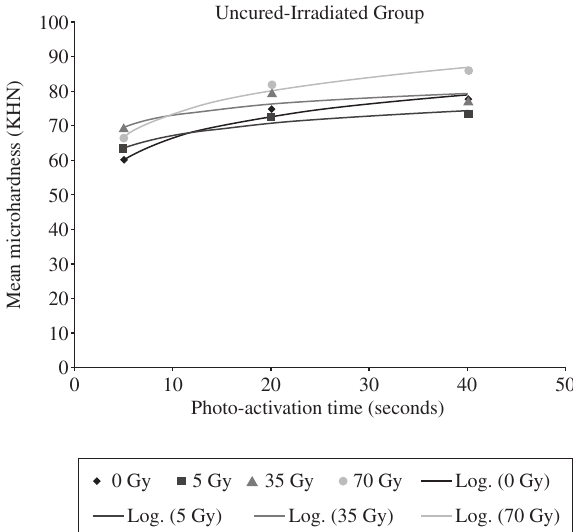
Figure 4. Regression analysis of degree of conversion of the Filtek Z250 TM material to cured-irradiated groups in accordance with radiation dose as a function of the photo-activation